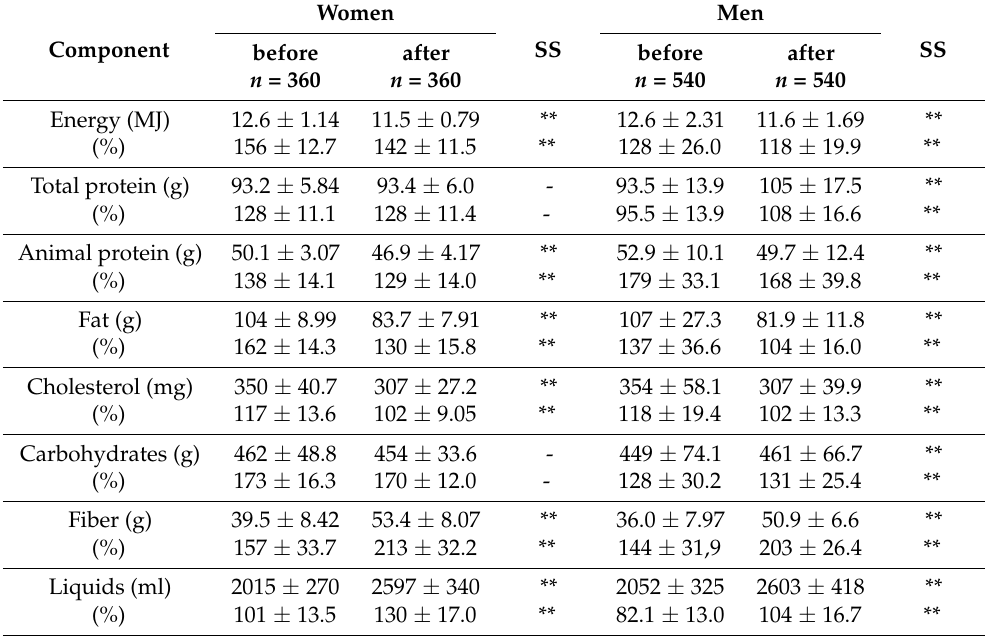
Table 1. The content of energy and basic nutrients in all-day food rations, including disc remnants, of − women and men; x ± SD, % of the recommended norm.